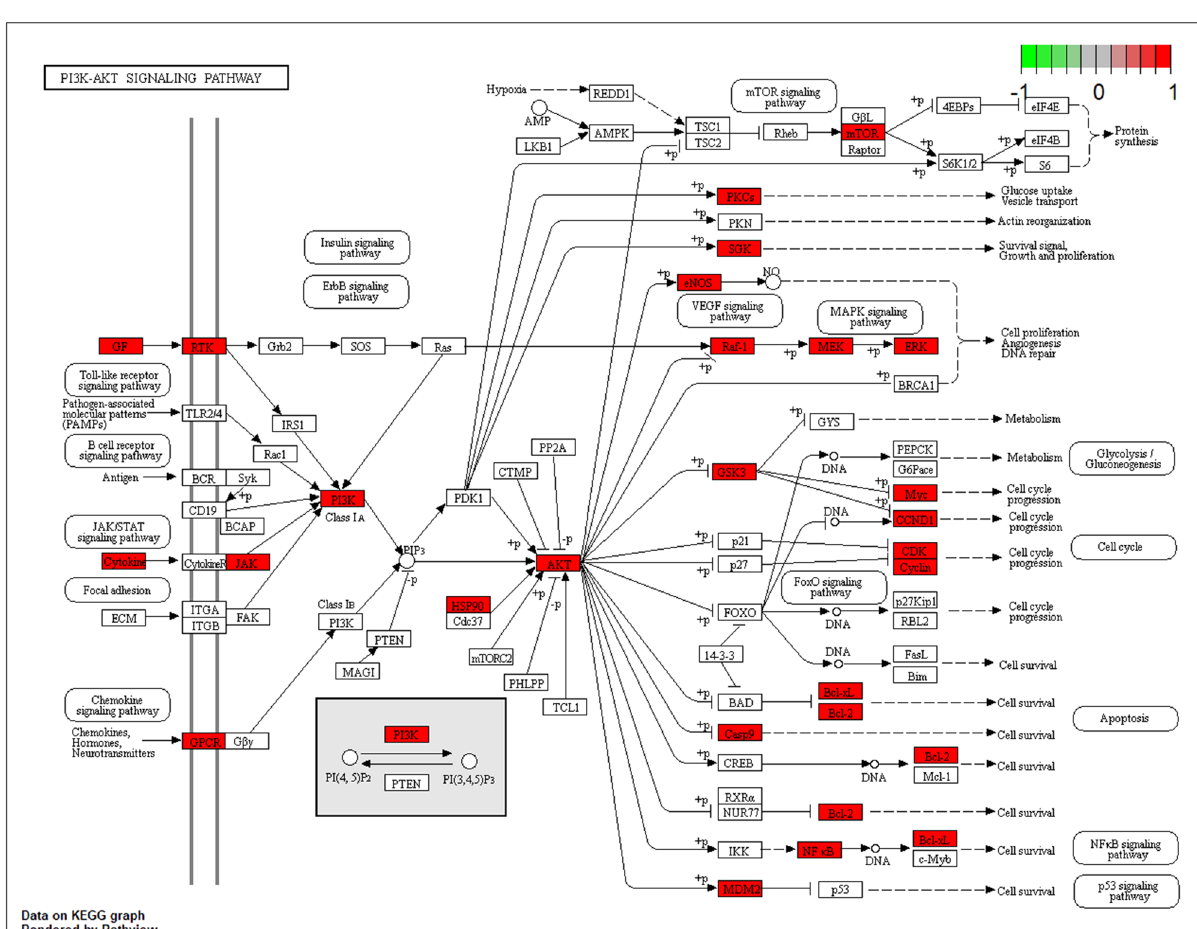
Figure 8. PI3K-AKT signaling pathway. The red rectangle represents the targets related to the core component- target-pathway